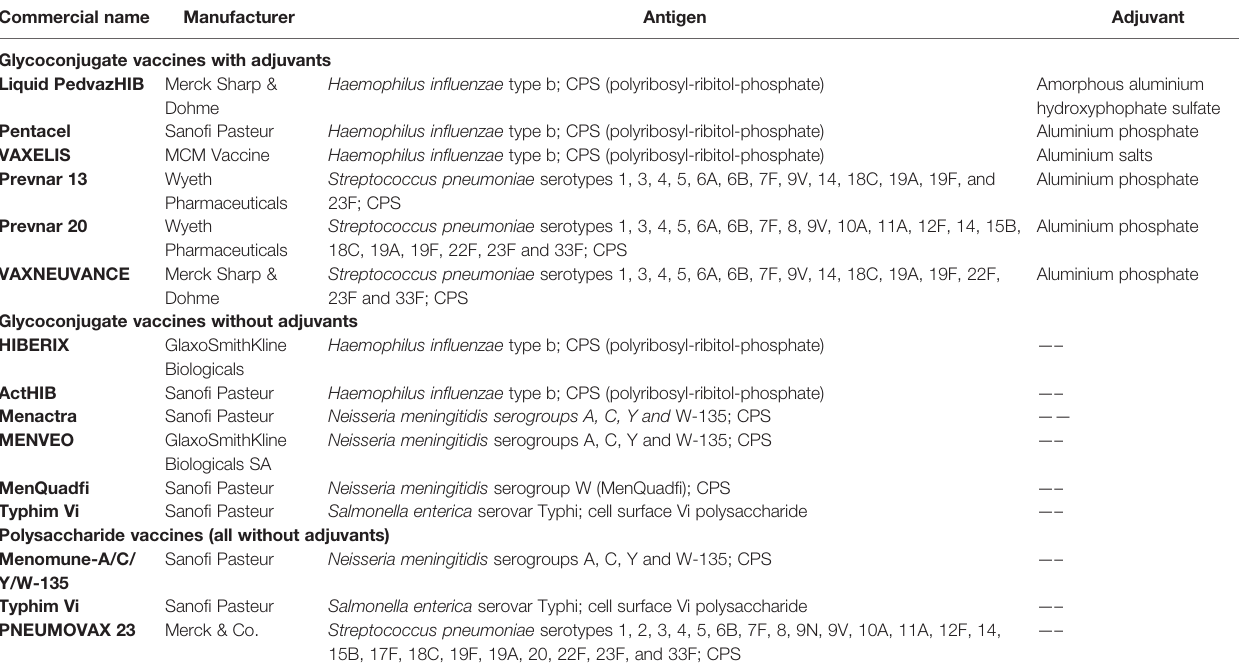
TABLE 1 | Carbohydrate-based vaccines approved by the